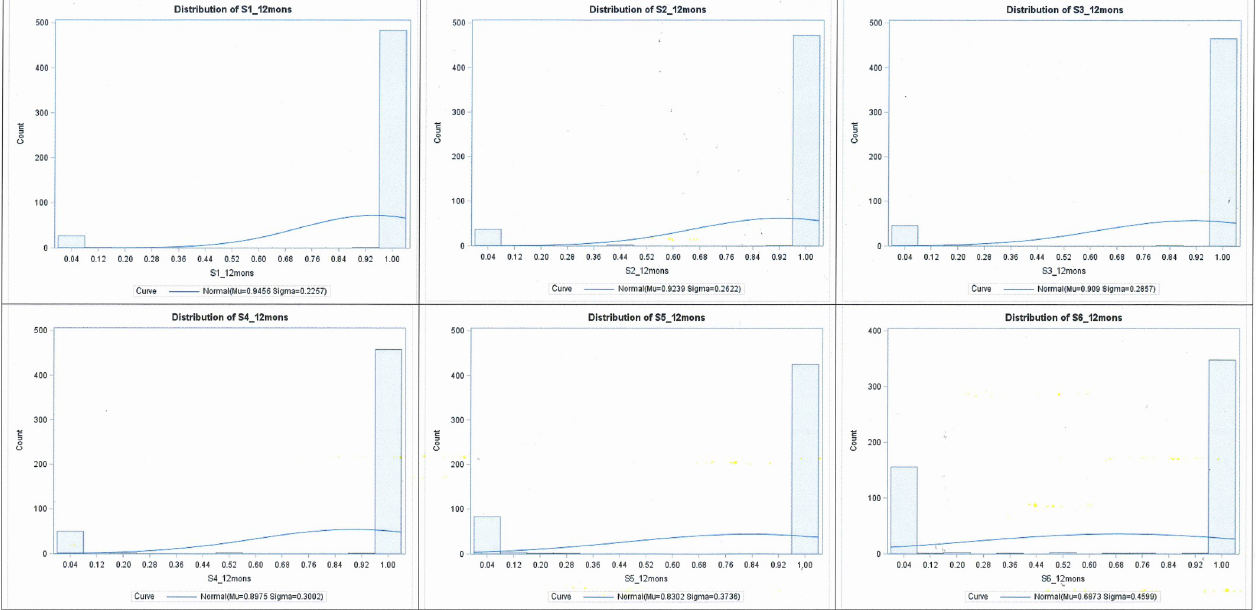
Fig 2. Standard gamble utility score distributions at the 12 months late stage cervical cancer. Legend: S1: Screened; cytology normal; S2: HPV positive with cytology normal; S3: Low grade cytology; S4: High grade cytology; S5: Early stage cervical cancer and S6: Late stage cervical